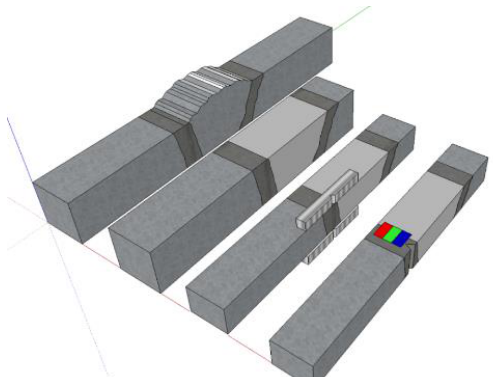
Figure 1. Sampling position. Color zones mark targeted areas for microstructural, hardness, and chemical analysis (red, green and blue).